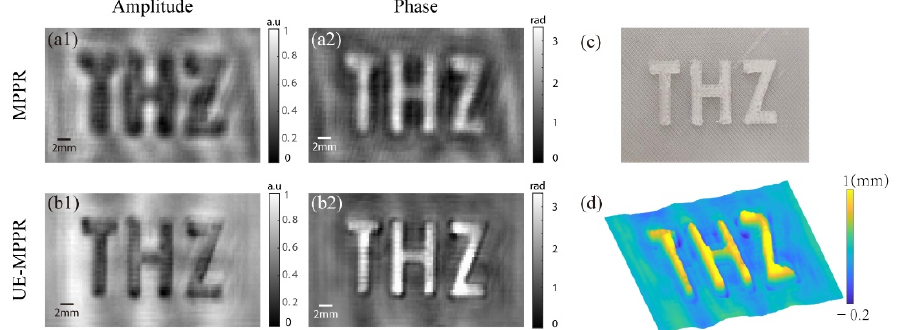
Figure 6. The reconstruction results of the 3D printing plate: ( a1 , b1 ) are the reconstructed amplitudes using MPPR and UE-MPPR method after 300 and 100 iterations, respectively; ( a2 , b2 ) are the corresponding reconstructed phases. ( c ) is the photo of the plate and ( d ) is the topography derived from ( b2 ).